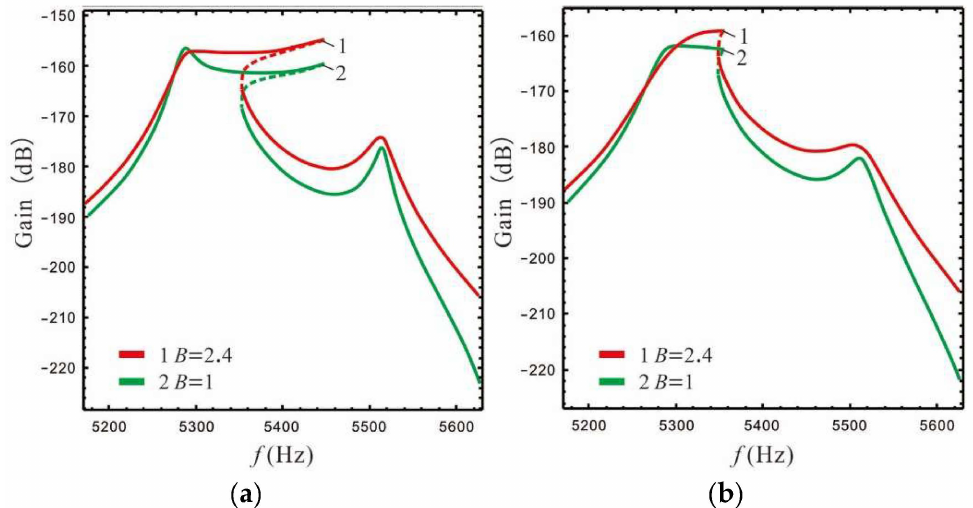
Figure 17. Gain and bandwidth are affected by damping coefficient for k d = 12.5; ( a ) ω x = 5320 × 2 π , P = 10 Pa, ( b ) ω x = 5320 × 2 π , P = 20 Pa